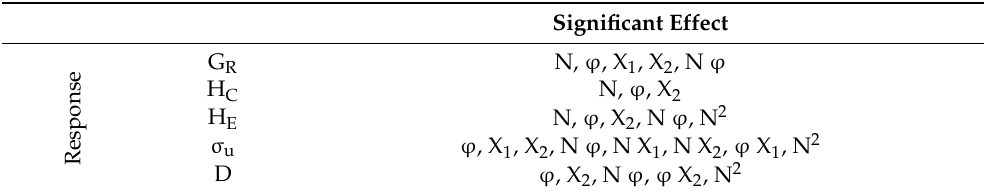
Table 3. Significant independent parameters for each ECAP